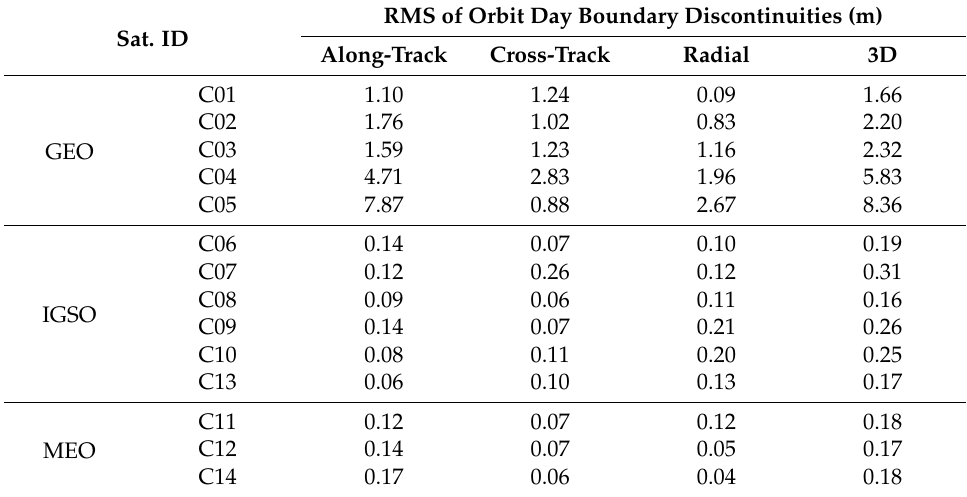
Table 1. RMS of DBDs in along-track, cross-track, radial, and 3D for GBM orbits during July 2017.